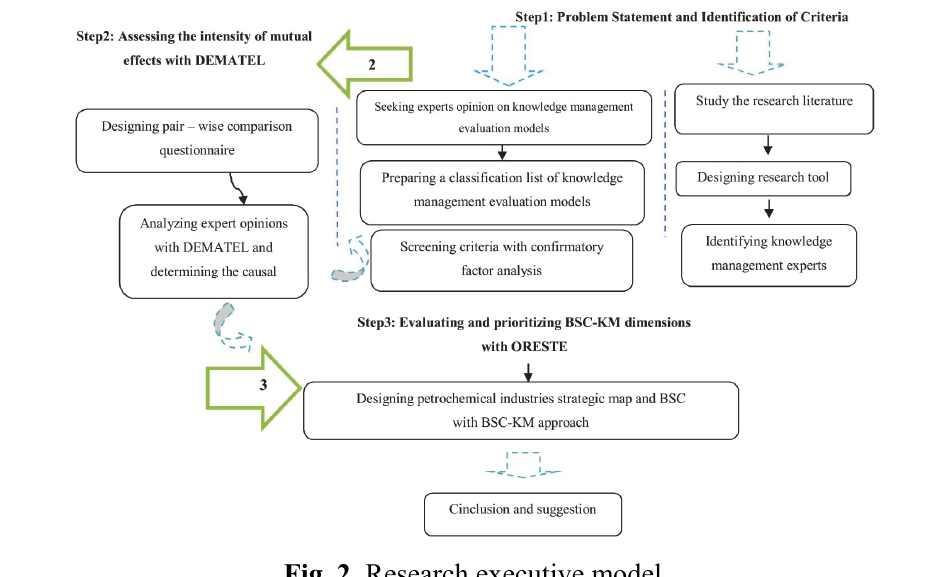
Fig. 2. Research executive